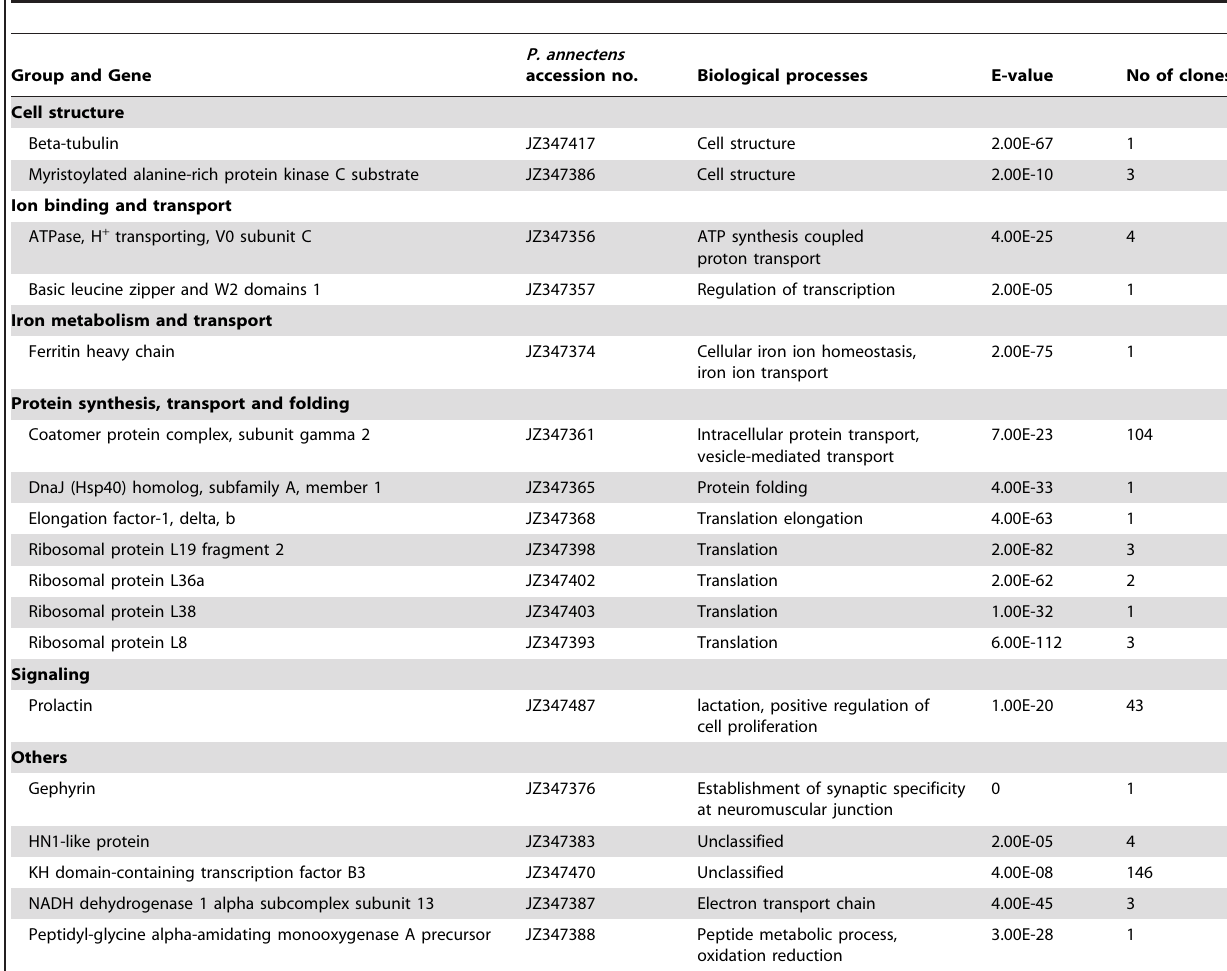
Table 5. Known transcripts found in the reverse library (down-regulation) obtained by suppression subtractive hybridization PCR from the brain of Protopterus annectens aestivated for 6 months in air with fish kept in freshwater as the reference for comparison.